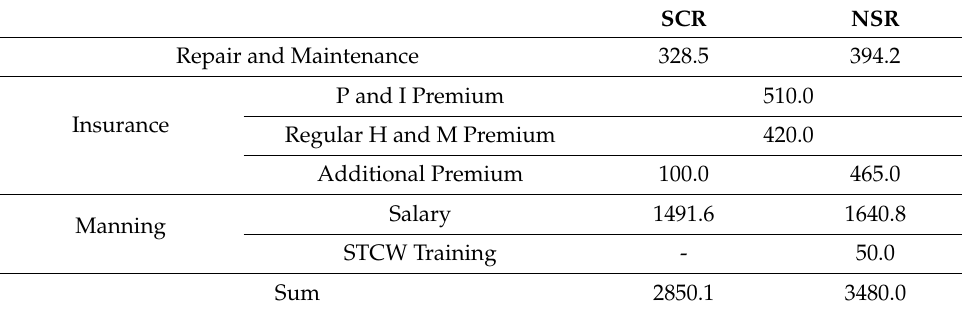
Table 6. Annual operational costs in thousands of